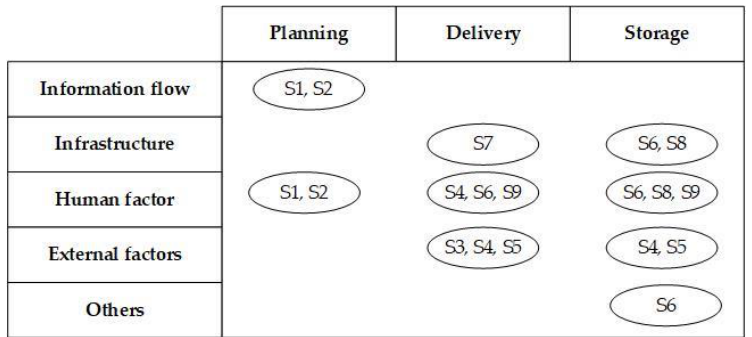
Figure 4. Matrix of classification of scenarios according to the criteria of the process and sources of risk.